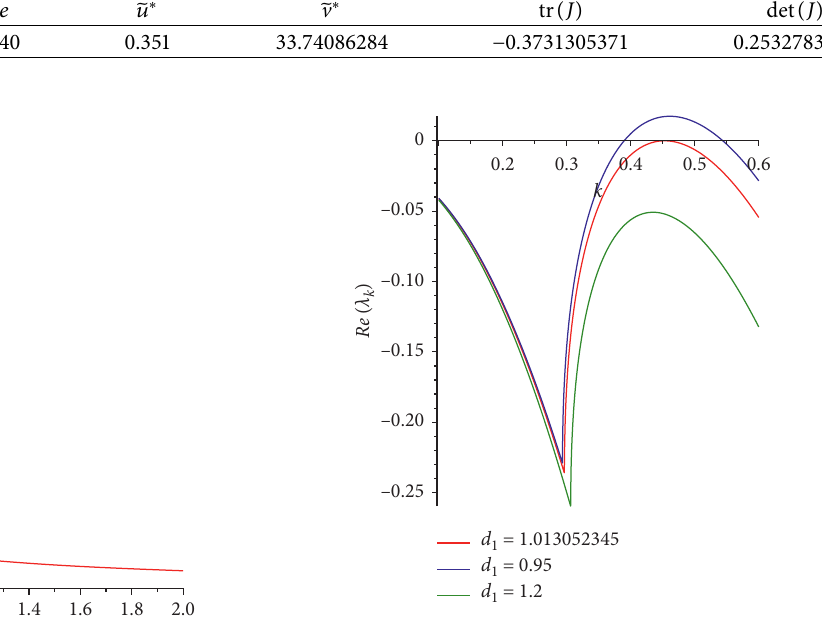
Figure 2: Dispersion relation of system (4), which shows the real part of eigenvalues of model